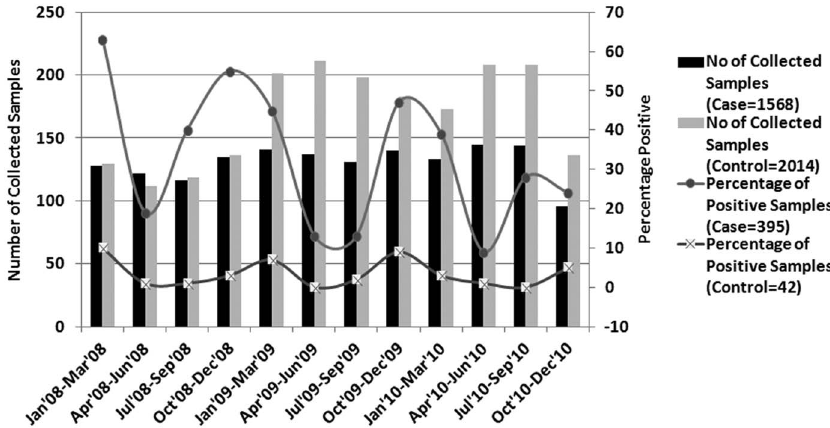
Figure 2. Seasonality of rotavirus in Kolkata. Seasonal distribution of the rotavirus positivity against total collected samples in Case and Control children in an urban slum community in Kolkata, India, during January 2008 through December 2010.